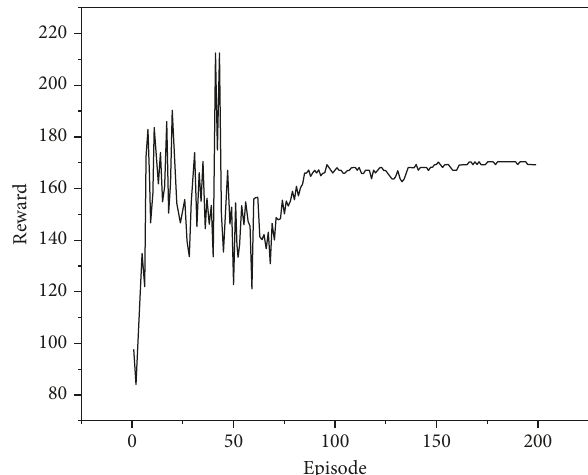
Figure 8: Training effect of reward shaping function.